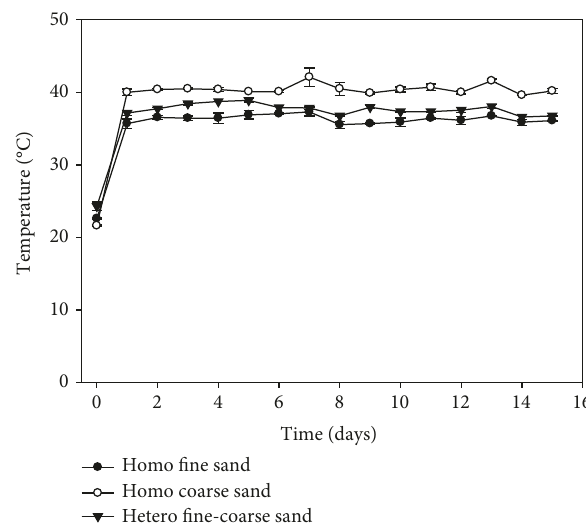
Figure 5: Dynamic variation in surface temperature with